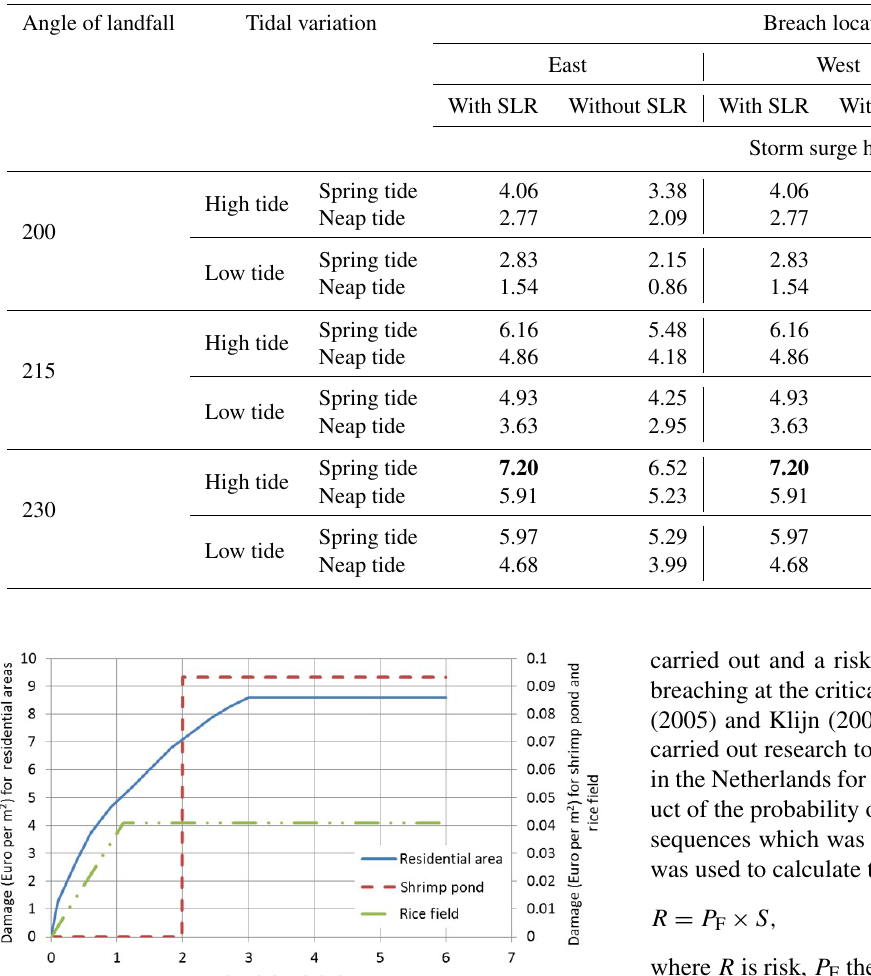
Table 2. Storm surge heights corresponding to different scenarios considered. The bold values are the storm surge height for the worst case scenarios.